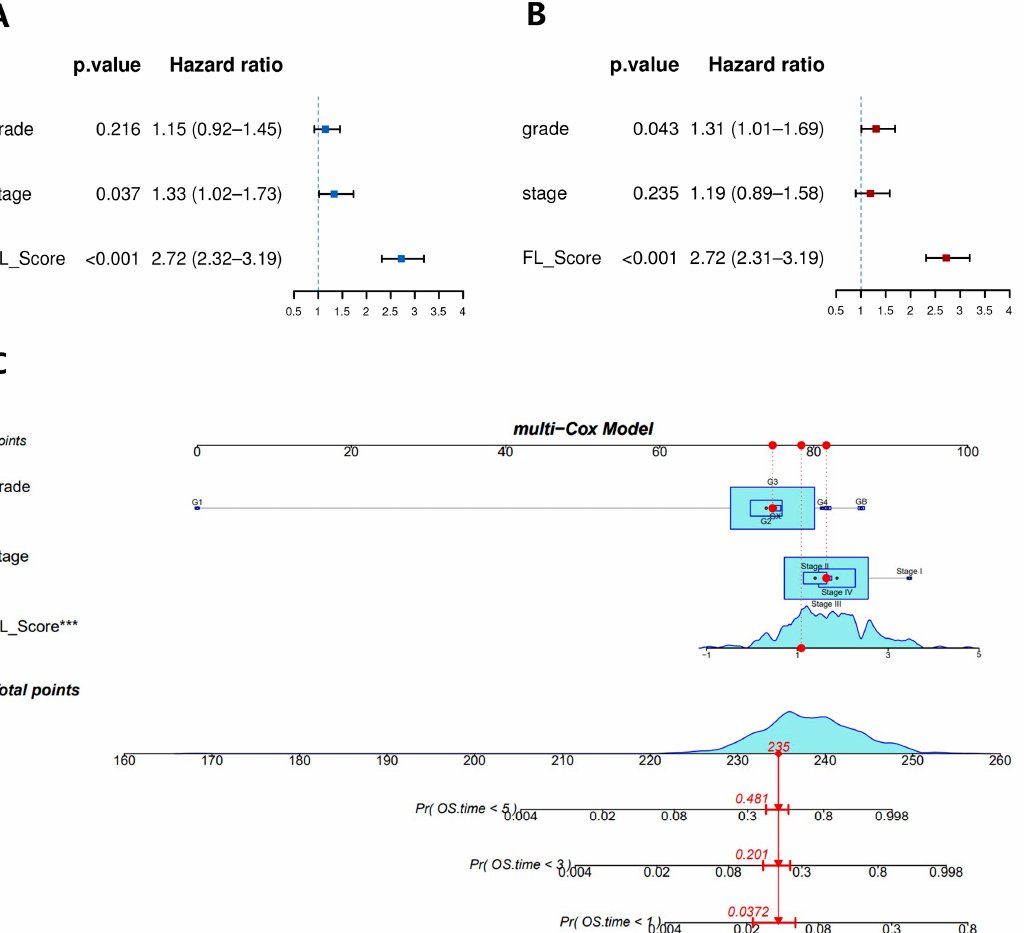
Figure 6. ( A ) Forest plot of univariate COX analysis. ( B ) Forest plot of multivariate COX analysis. ( C ) A nomogram for both clinicopathological factors and ferroptosis-related lncRNA score (FL_score). *** ( p <